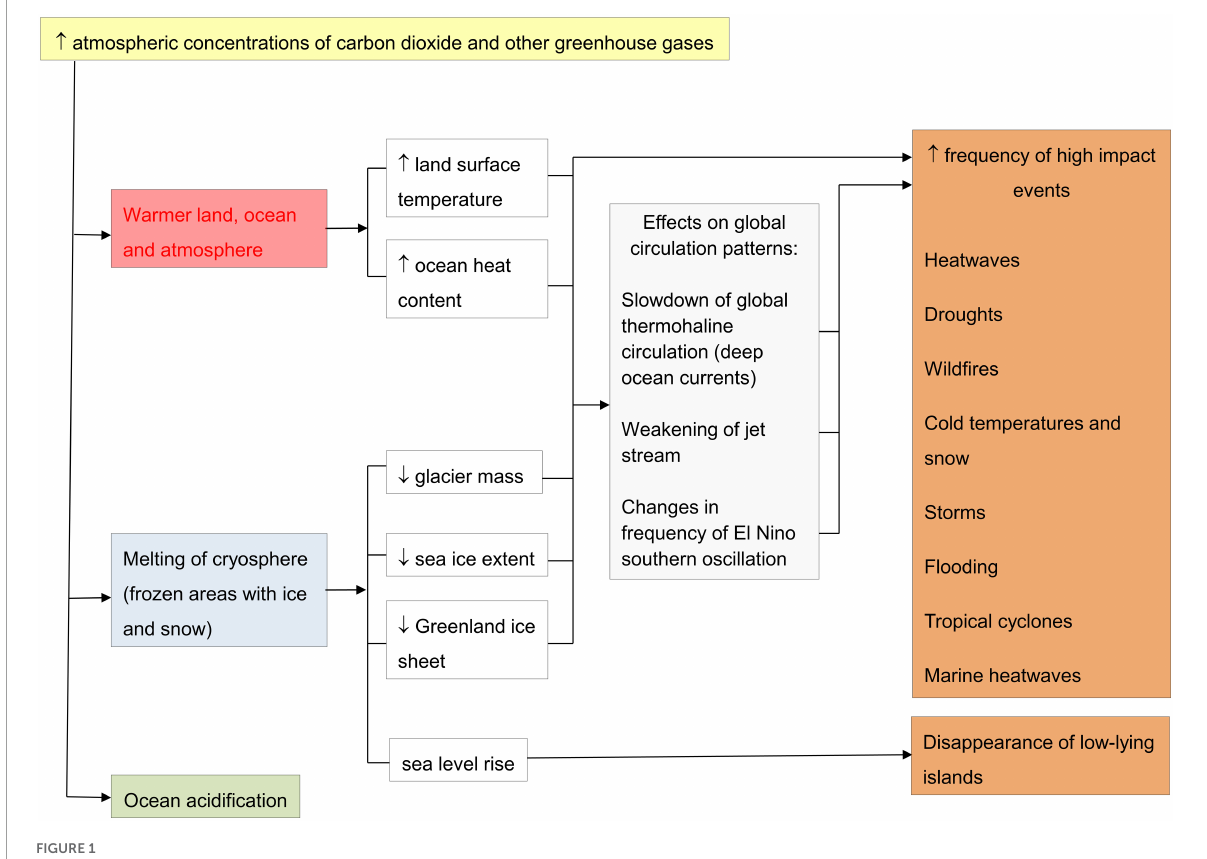
FIGURE1 Effects of increasing atmospheric concentrations of carbon dioxide and other greenhouse gases on climate and weather [based on (World Meteorological Organization,